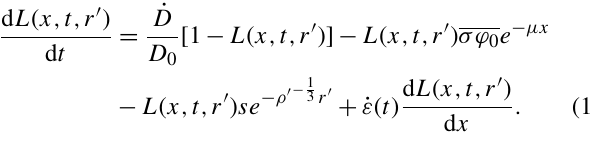
Surface erosion